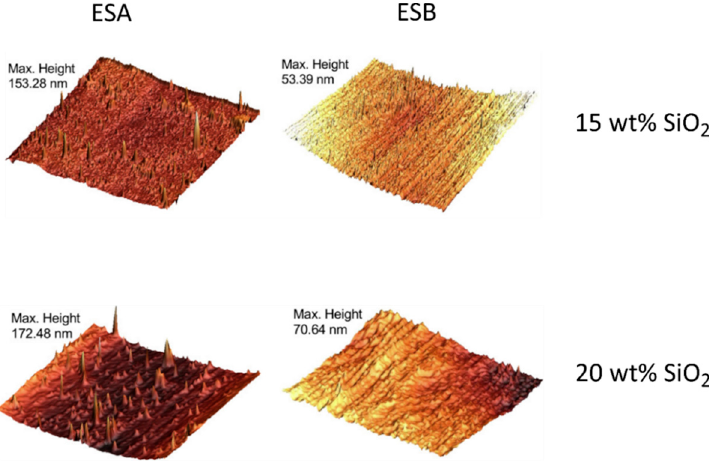
Figure 7. 3D atomic force microscopy (AFM) micrographs showing the surface morphology of epoxy nanocomposites (15 and 20 wt % of SiO 2 ). The ESA (epoxy silica A) hybrids ( left ) were prepared without 3-glycidyloxypropyltrimethoxysilane (GPTMS), and the ESB (epoxy silica B) hybrids ( right ) were prepared with GPTMS. The peaks represent silica nanoparticles and/or agglomerates, and the SiO 2 is distributed more homogeneously and less agglomerated when GPTMS is used. Reproduced with permission from Afzal and Siddiqi, Polymer ; published by Elsevier Ltd., Amsterdam, The Netherlands, 2011.